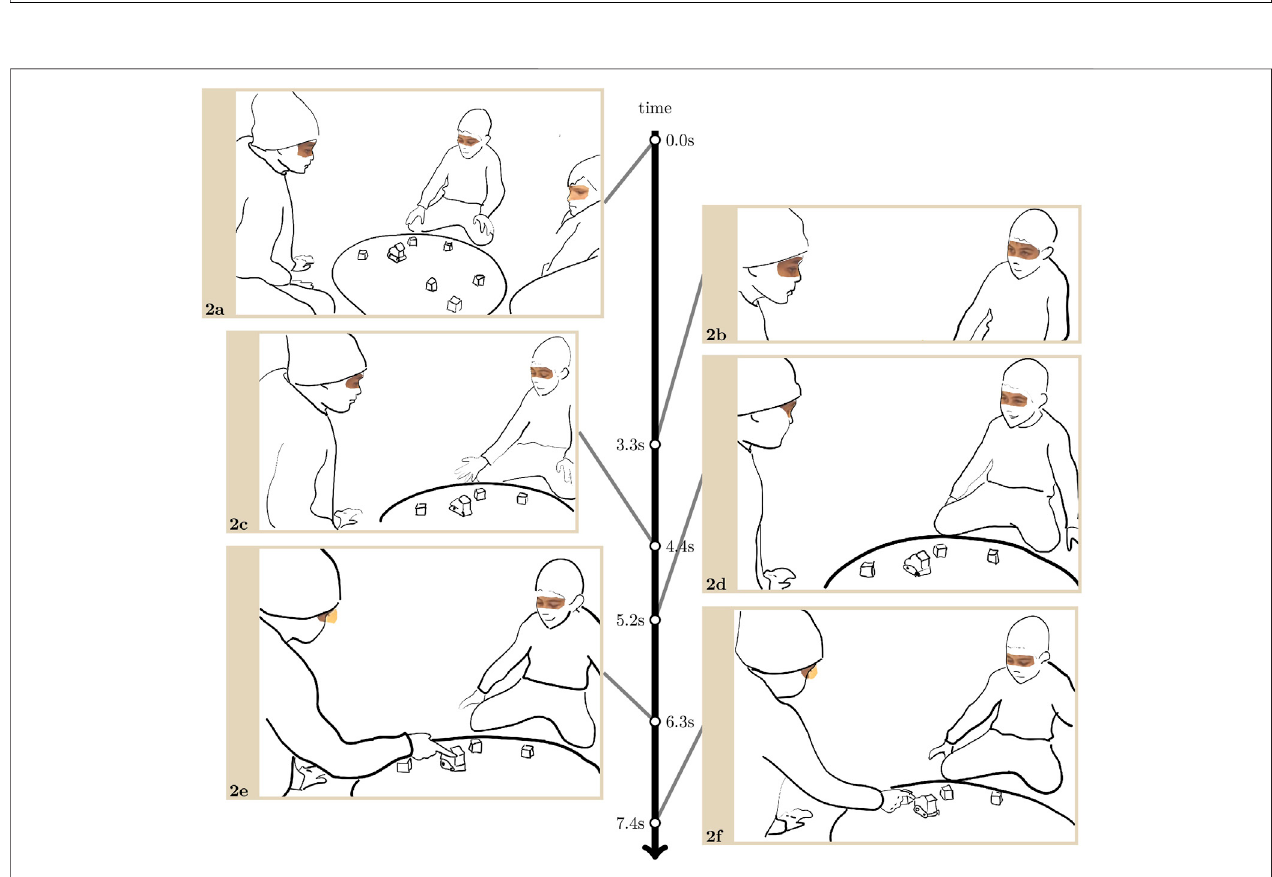
Frontiers in Robotics and AI |